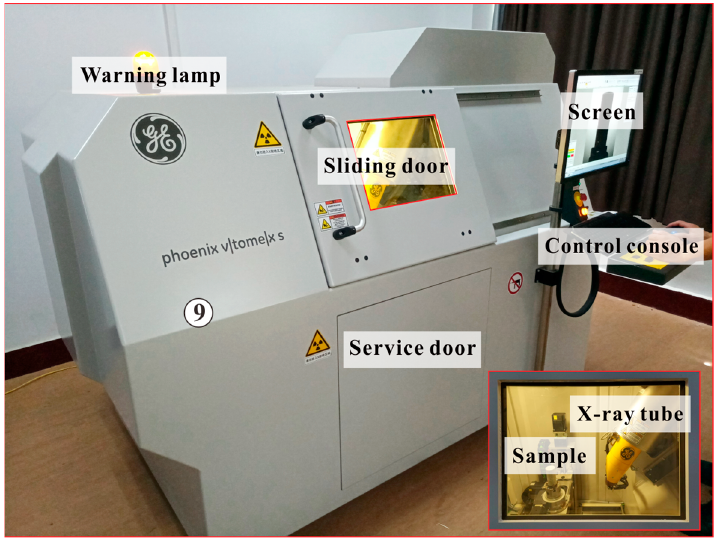
Figure 8. Apparatus for computed tomography (CT) test.